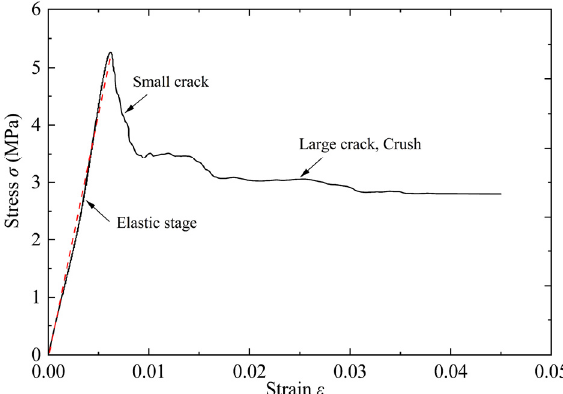
Figure 3. Quasi-static compression stress-strain curve of foamed concrete.